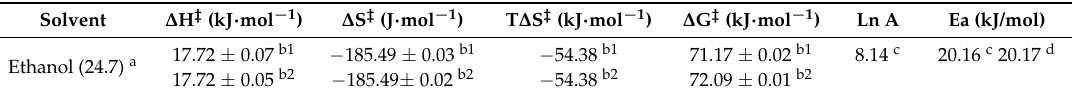
Table 3. Activation parameters for the reaction between compounds TPP, DMAD and MA measured in the solvent ethanol.